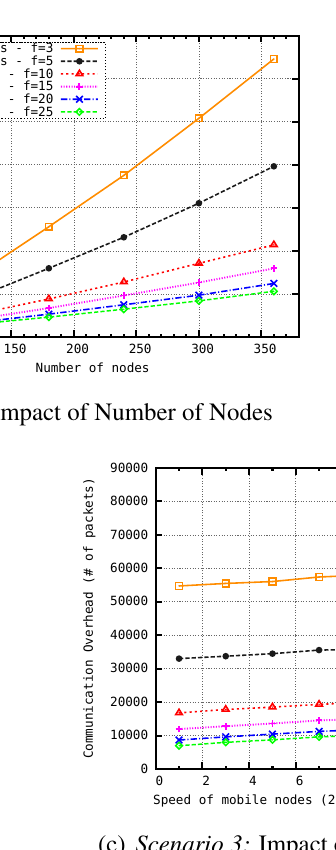
Figure 12. Communication Overhead for different frequencies of global